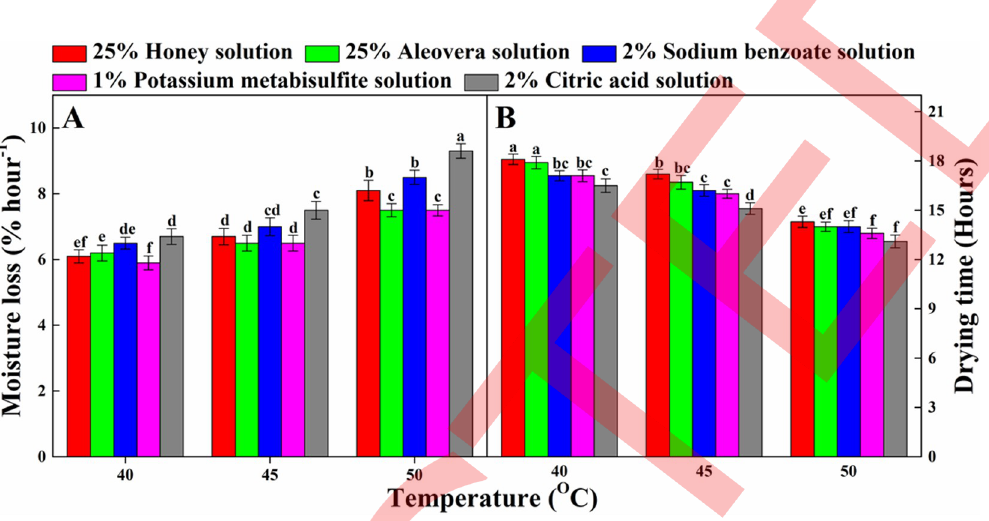
Fig 2. The interaction effect of drying temperature and preservatives on moisture loss (A) and drying time (B) of persimmon fruit. Bars in the figure represent means ± S.E. (n = 3), and means sharing the same letters are non-significant at p <